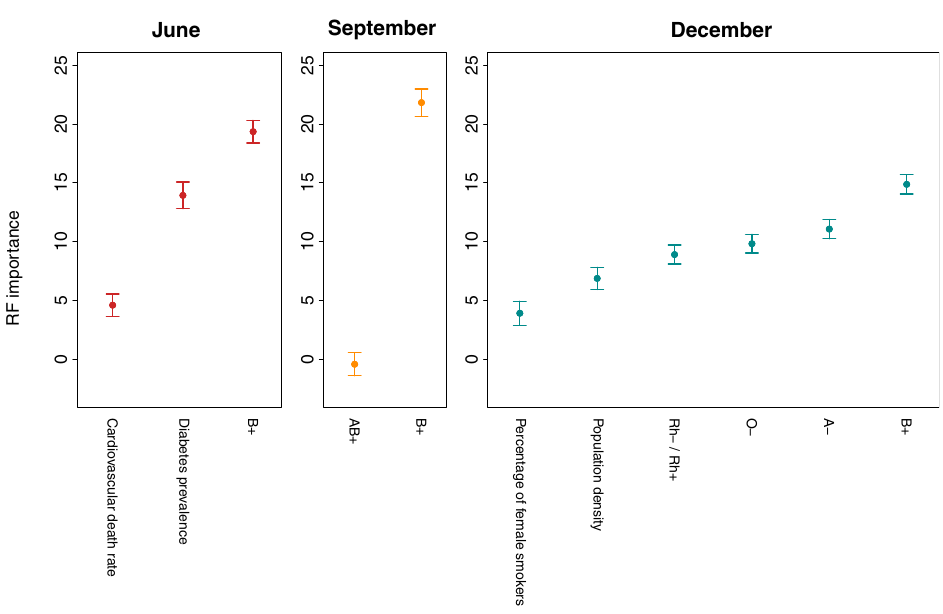
Figure 4. Average importance of the variables used in the RF model over 100 runs of the RF algorithm, with the respective standard deviations. R base package graphics 4.0.5 was used to generate the